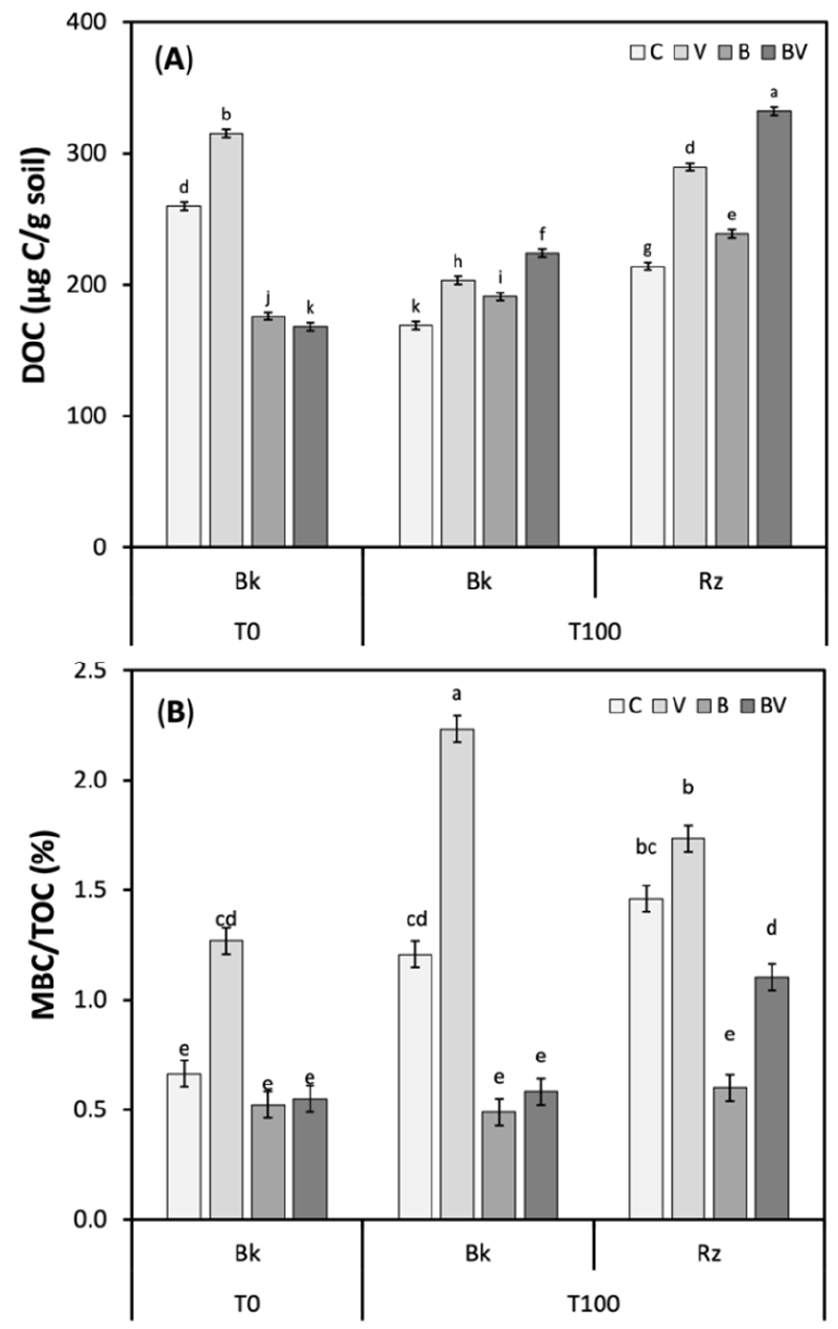
Figure 2. Microbial biomass C ( A ) and MBC percentage of total organic C ( B ) in the bulk (Bk) and rhizosphere (Rz) soils amended with different fertilisers at the start (T0) and end (T100) of tomato cultivation. CTR—control; V—vermiwash; B—biochar; BV—biochar together with vermiwash. Bars represent SE of the interaction sample time × fertiliser × soil region. Different letters indicate significant differences among treatments ( p < 0.05; Tukey’s test).